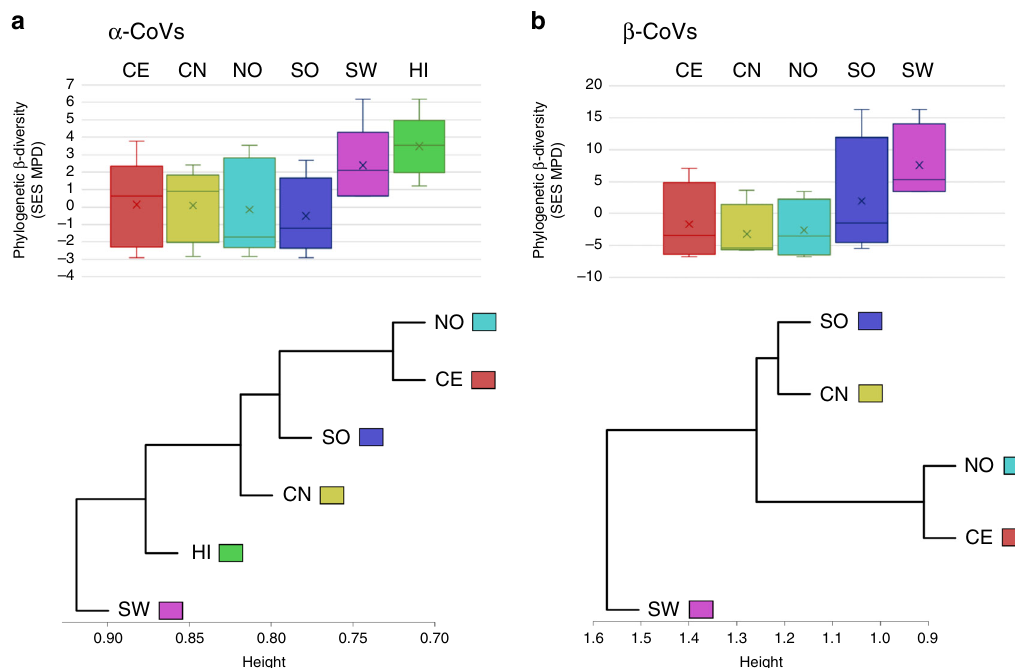
Fig. 9 Phylogenetic diversity. Standardized effect size of mean phylogenetic distance (SES MPD) and phylogenetic ordination among zoogeographic regions for α -CoVs ( a ) and β -CoVs ( b ). Boxplots for each region show the mean (cross), median (dark line within the box), interquartile range (box), 95% con fi dence interval (whisker bars), and outliers (dots), calculated from all pairwise comparisons between regions ( n = 15 for α -CoVs and n = 10 for β - CoVs). NO Northern region, CN Central northern region, SW South western region, CE Central region, SO Southern region, HI Hainan